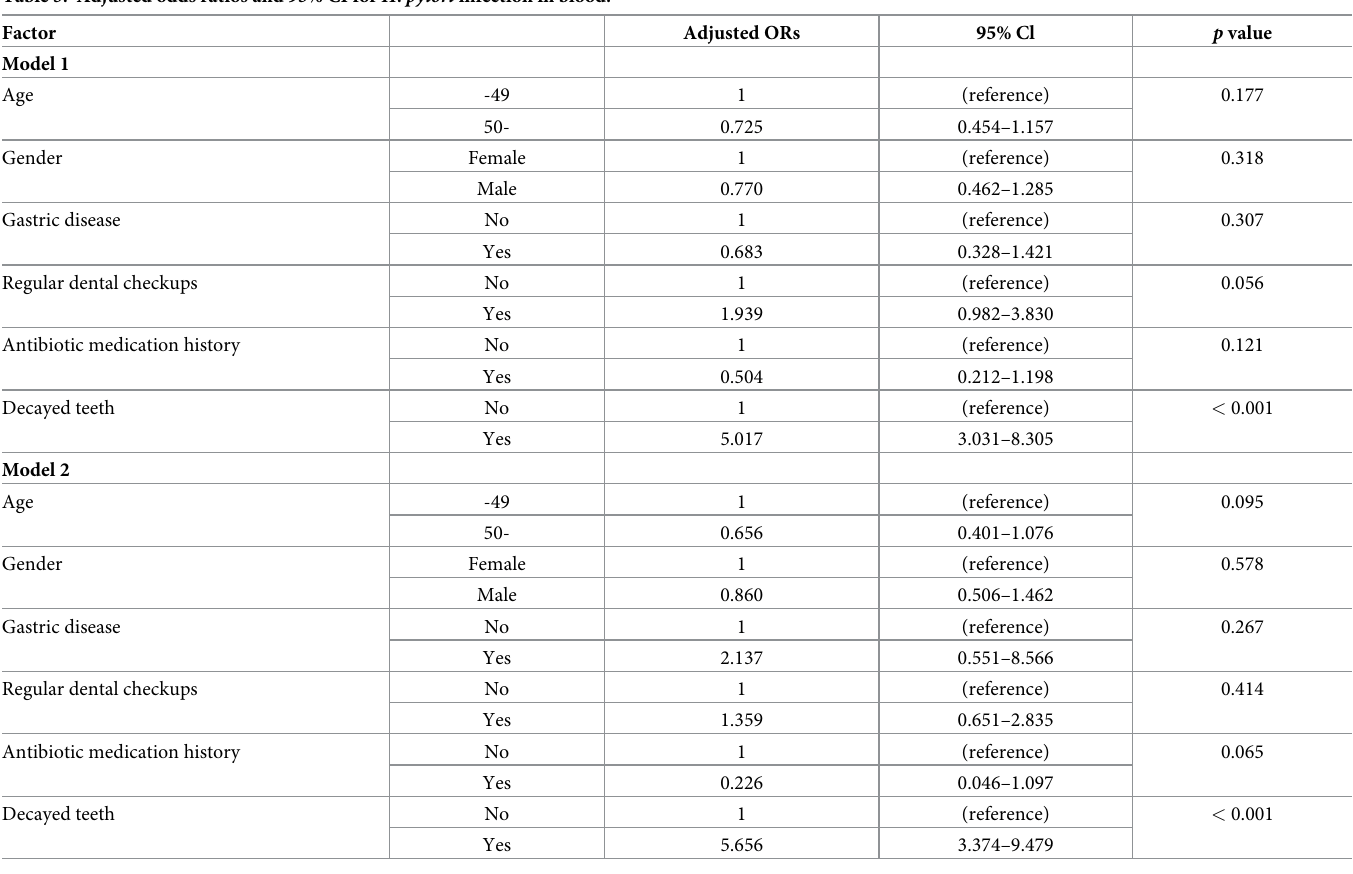
Table 3. Adjusted odds ratios and 95% CI for H . pylori infection in blood.